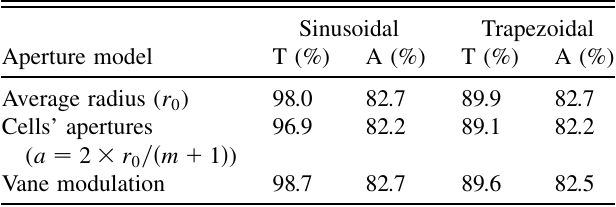
TABLE VIII. Effect of the choice of the aperture model on the calculation of the RFQ transmission for both the sinusoidal and trapezoidal designs. T is the total transmission and A is the acceleration efficiency.